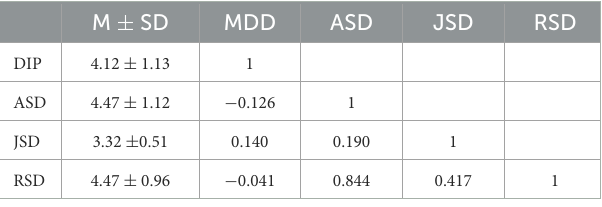
TABLE 4 Pearson correlation analysis between sub-dimensions of athlete mindfulness scale and